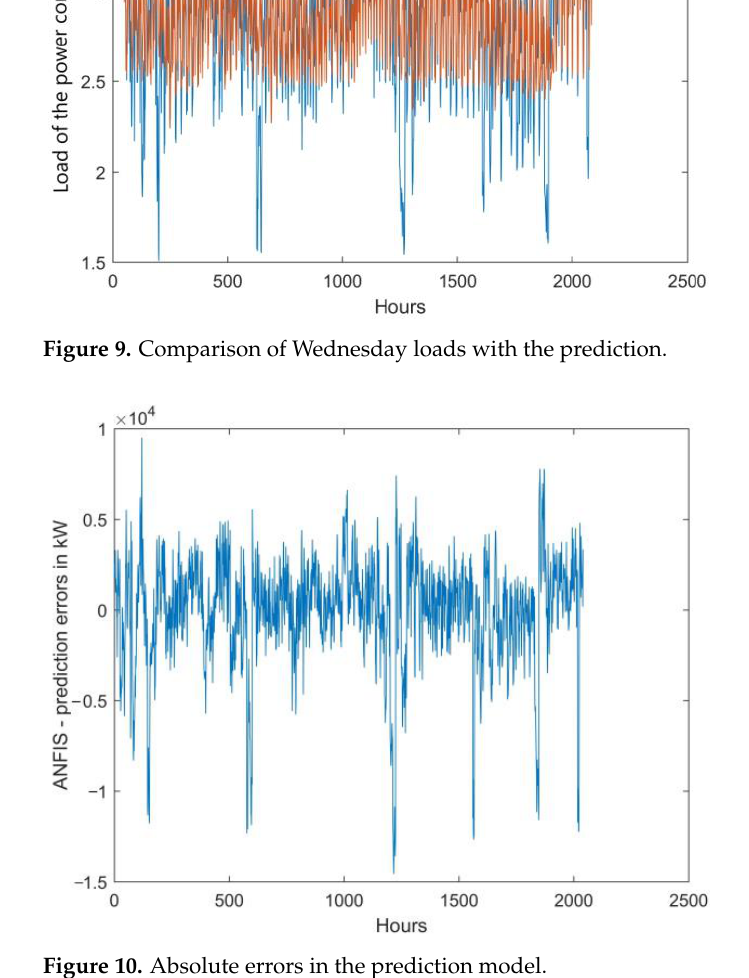
Figure 10. Absolute errors in the prediction model.